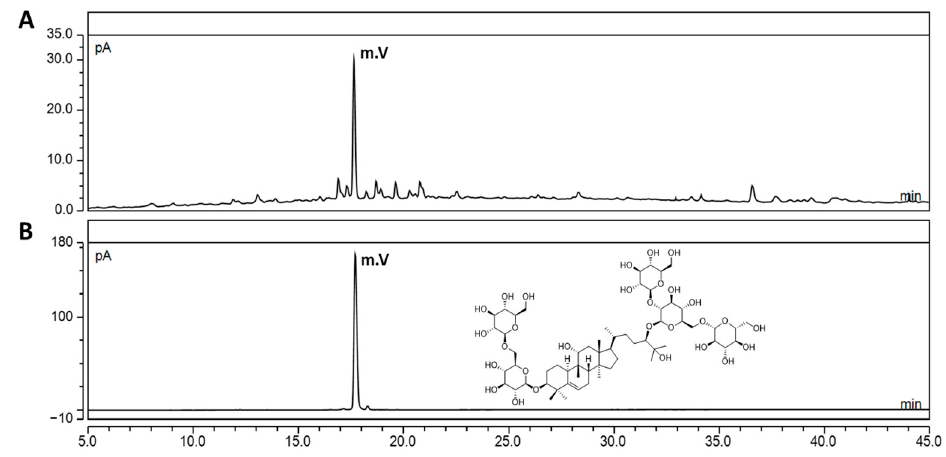
Figure 1. UHPLC - CAD chromatogram of SGRE ( A ) and MV of standard compound ( B ). Chemical structure of MV. The MV concentration was 1 mg/mL.